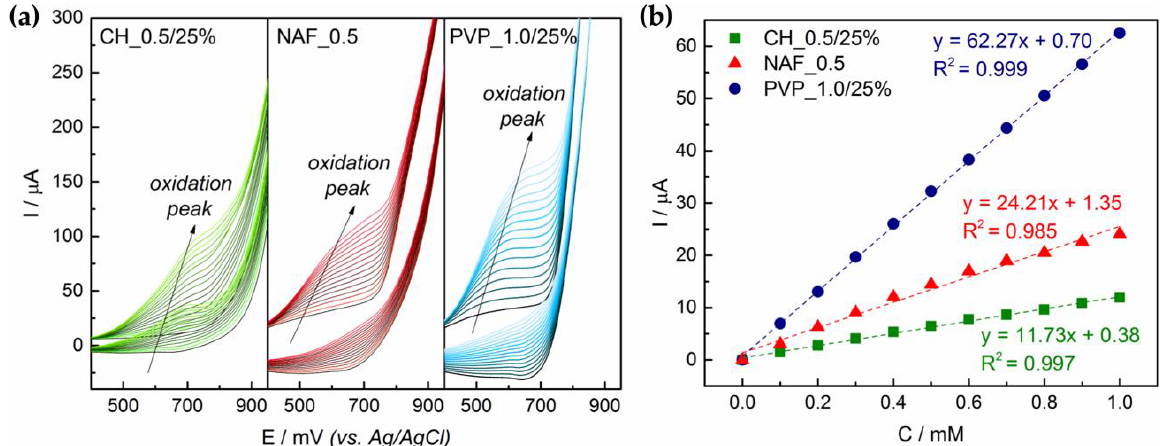
Figure 7. Electrochemical performance of the electrodes based on CH_0.5/25%, CH_0.5/5% and CH_0.5/25% suspensions: ( a ) voltammograms for glucose concentration range 0−1.5 mM; ( b ) regression lines glucose concentration versus generated current (step 0.1 mM).